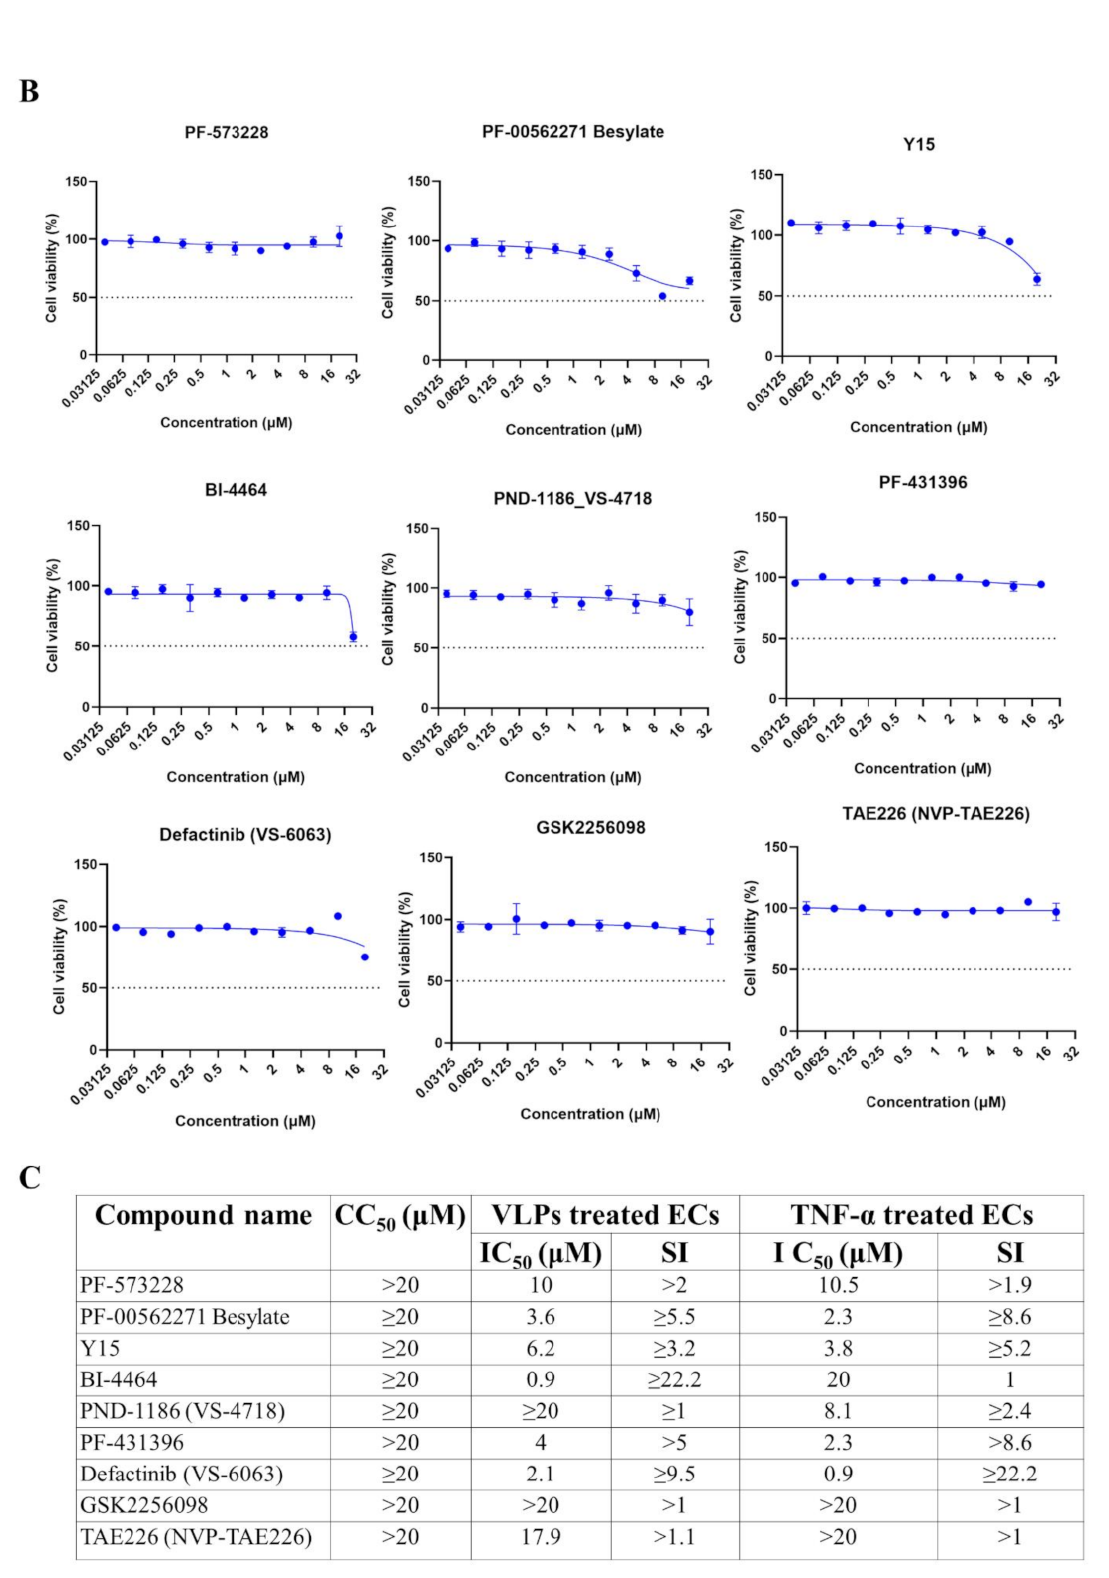
Figure 7. Dose-response curves of potent FAK inhibitors. ( A ) ECs were pretreated for 1 h at 37 ◦ C with 10 increasing doses (0.0390625, 0.078125, 0.1562, 0.3125, 0.625, 1.25, 2.5, 5, 10, and 20 µ M) of PF- 573228, PF-00562271 Besylate, Y15, BI-4464, PND-1186 (VS-4718), PF-431396, Defactinib (VS-6063), GSK2256098, and TAE226 (NVP-TAE226) before the addition of TNF- α (10 ng/mL) or VLPs (10 × ) for 12 and 48 h incubation, respectively. Cells were then subjected to immunofluorescence assay